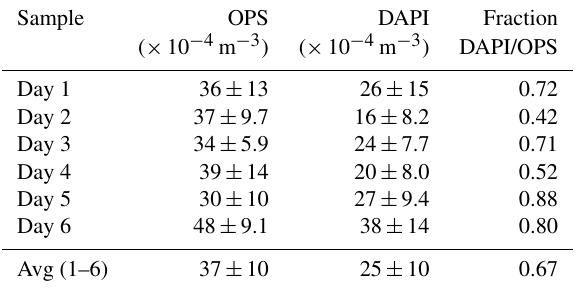
Table 3. Mean diel aerosol number concentrations at 60m height obtained by an optical particle sizer (OPS) and by bioaerosol stain- ing with DAPI (avg ± SD). The fraction of DAPI-stained particles in relation to total aerosol numbers in the same size range provides an estimation of presumably intact cells vs. degraded biological ma-